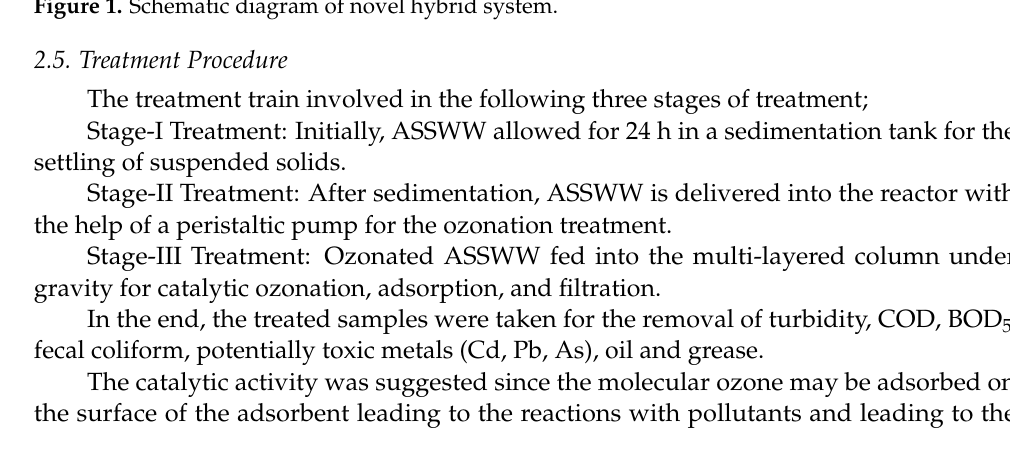
Figure 1. Schematic diagram of novel hybrid system .